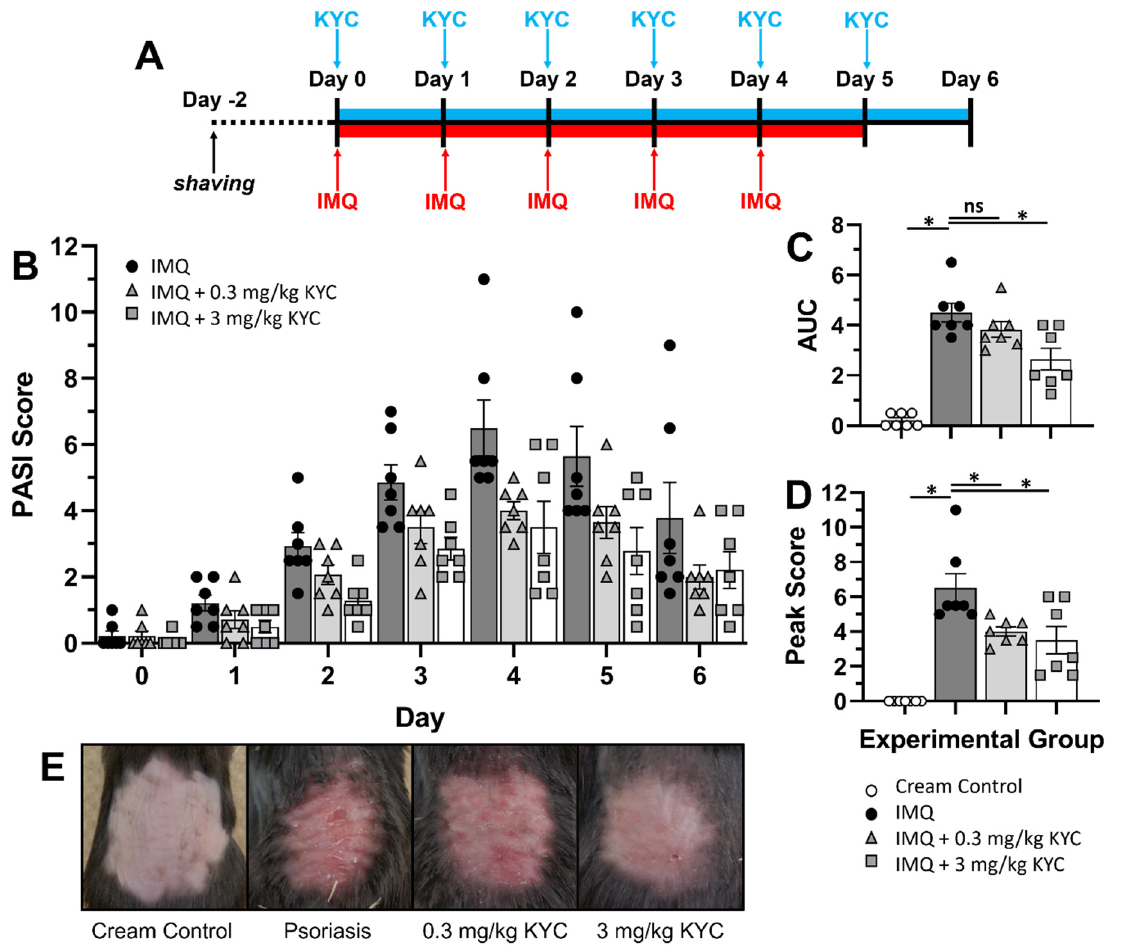
Figure 3. Systemic administration of KYC ameliorates plaque psoriasis in mice. Mice were shaved on the back two days before psoriasis induction. At the experiment start, mice were systemically IP administered KYC or PBS alone daily for six days and at the same time, IMQ cream was applied daily for five days. ( A ) Experimental timeline and treatment regimen is shown. ( B ) Average daily PASI scores for each condition are shown. ( C ) AUC from the entire disease course was calculated from the individual daily scores. ( D ) Peak psoriasis incidence on day 4 is shown. ( E ) Representative skin images were recorded at peak psoriasis (day 4). Cream control = white circles; IMQ psoriasis = black circles; IMQ + 0.3 mg/kg KYC = gray triangles; IMQ + 3 mg/kg KYC = gray squares. Each data point represents one mouse. Data shown are the mean and SEM ( B – D ). Data include two replicate experiments containing 3–4 mice per group ( A – D ). * p ≤ 0.05.